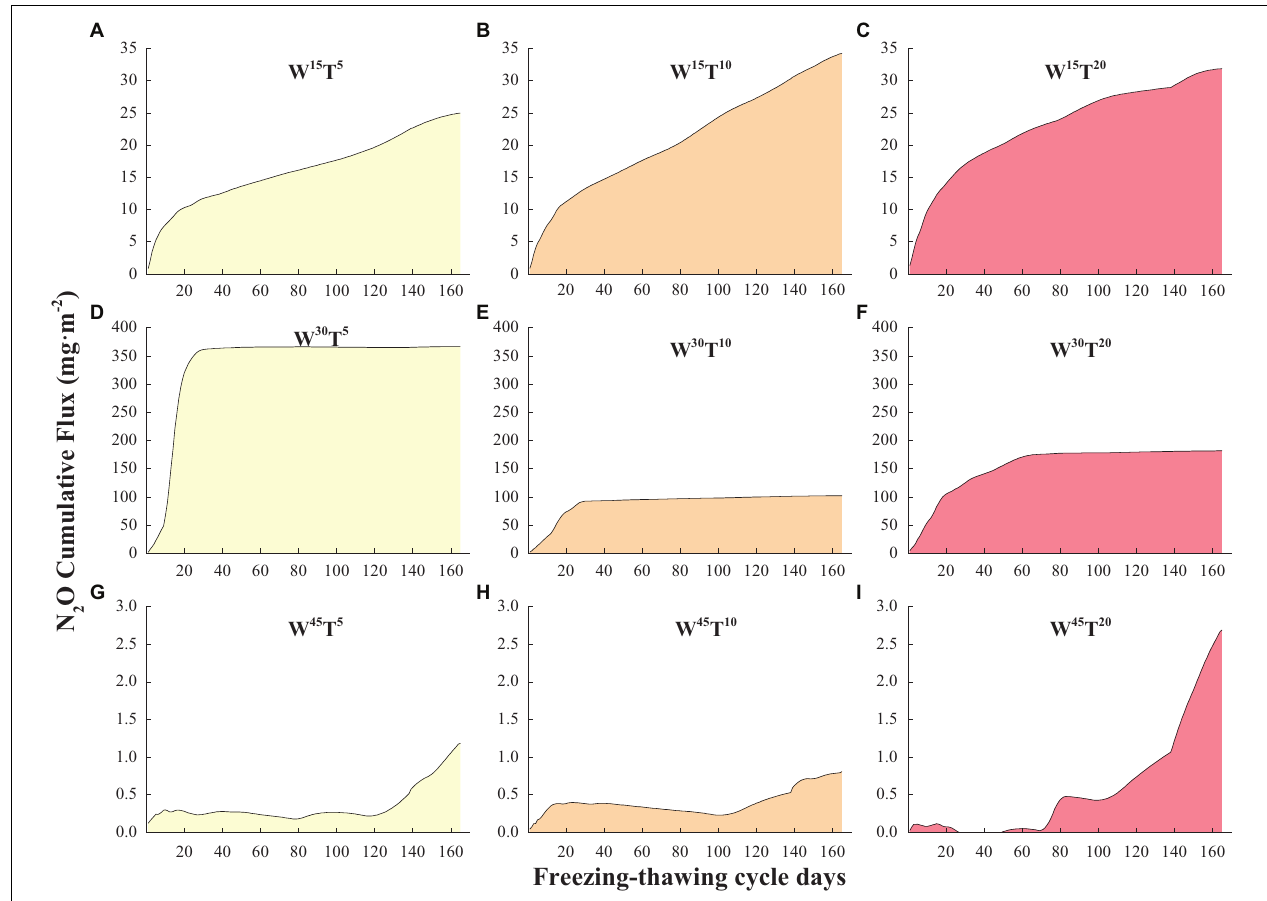
FIGURE 2 | The patterns of cumulative N 2 O emissions under the treatments of (A) W 15 T 5 , (B) W 15 T 10 , (C) W 15 T 20 , (D) W 30 T 5 , (E) W 30 T 10 , (F) W 30 T 20 , (G) W 45 T 5 , (H) W 45 T 10 , and (I) W 45 T 20 . The slope of the tangent lines represent the intensity of cumulative emission.